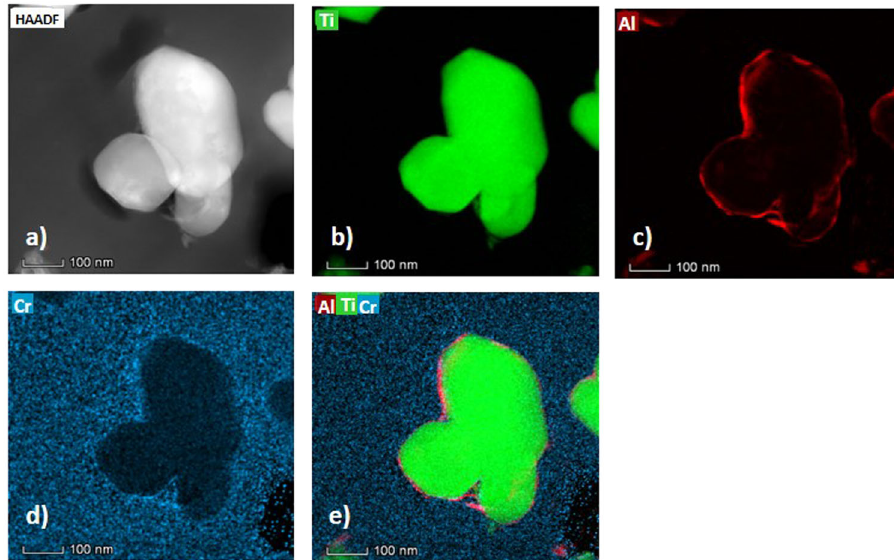
Fig. 4 High-magni fi cation STEM/EDS analysis of 30TiO 2 fi lm after exposure to Na 2 CrO 4 solution in water/acetone for 24 h at 60 °C. a STEM lamella of 30TiO